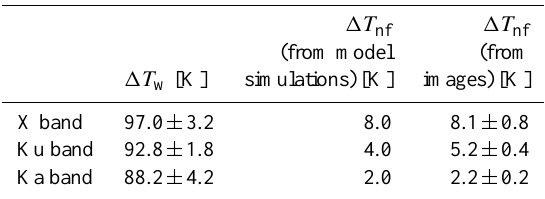
Table 3. Parameters of the water level retrieval algorithm.